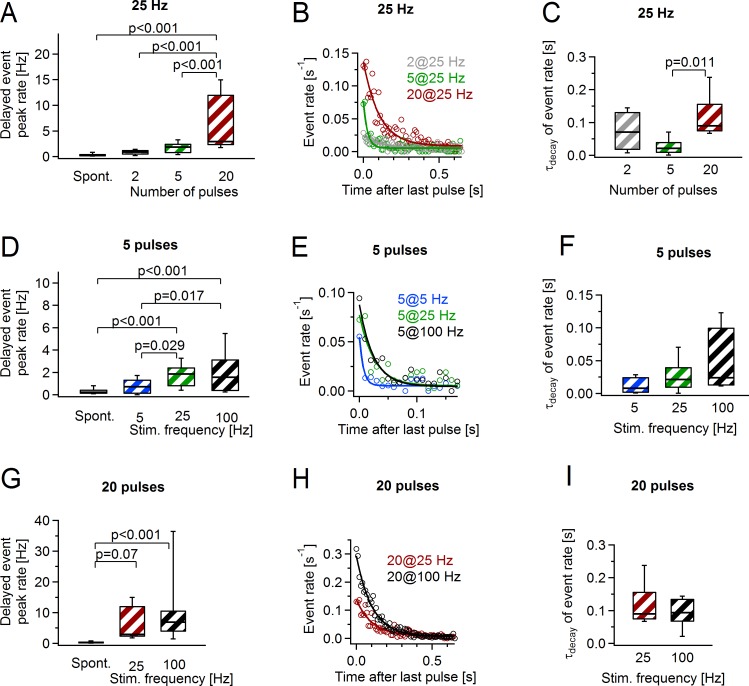
The rate and the time course of delayed glutamate release at axon-oligodendrocyte precursor cell (OPC) synapses depend on the stimulation paradigm.(A) Average peak rate of the delayed events after the stimulation with 2 pulses (n = 6 cells), 5 pulses (n = 6 cells), or 20 pulses (n = 8 cells) at 25 Hz. The box “Spont.” shows the frequency of the spontaneous events recorded before each stimulation train. One-way ANOVA (S7 Data). (B) Average rate of delayed events after the stimulation with 2, 5, or 25 pulses at 25 Hz. Solid lines indicate monoexponential fits to the events rate. The same cells used as in (A). (C) Average decay time constants of the delayed events rate after the stimulation with 2, 5, or 20 pulses at 25 Hz. The same cells used as in (A). One-way ANOVA (S7 Data). (D) Data and statistical comparisons are as in (A) but for the stimulation paradigms of 5 pulses at 5 Hz (n = 7 cells), 25 Hz (n = 7 cells), and 100 Hz (n = 6 cells). One-way ANOVA (S7 Data). (E) Data as in (B) but for the stimulation paradigms of 5 pulses at 5, 25, and 100 Hz. The same cells used as in (D). (F) Data and statistical comparisons are as in (C) but for the stimulation paradigms of 5 pulses at 5, 25, and 100 Hz. The same cells used as in (D). One-way ANOVA (S7 Data). (G) Data and statistical comparisons are as in (A) but for the stimulation paradigms of 20 pulses at 25 Hz (n = 8 cells) and 100 Hz (n = 13 cells). One-way ANOVA (S7 Data). (H) Data as in (B) but for the stimulation paradigms of 20 pulses at 25 and 100 Hz. The same cells used as in (G). (I) Data and statistical comparisons are as in (C) but for the stimulation paradigms of 20 pulses at 25 and 100 Hz. The same cells used as in (G). One-way ANOVA (S7 Data). Box and whisker plots: the bottom and top of each box represent 25th and 75th percentiles of the data, respectively, while whiskers represent 10th and 90th percentiles. The midline represents the median. The numerical data used in A, C, D, F, G, and I are included in S8 Data.